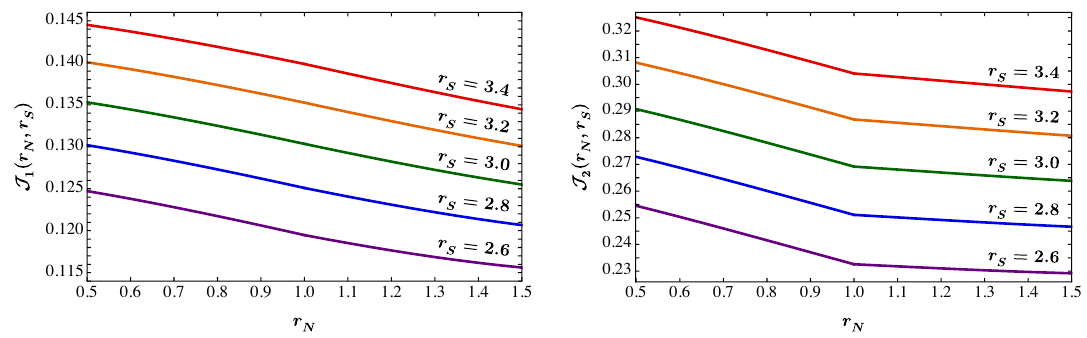
and J as functions of r 1 2